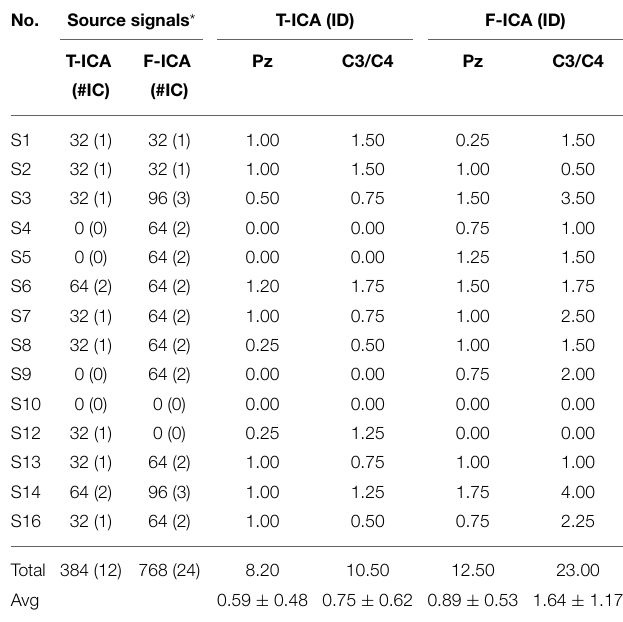
* Numberofsourcesignalswasdefinedasthenumberofelectrodes32timesthenumber of Independent Components (#IC; Figures 4 , 7 ) found for each patient. The number of source signals from all 14 patients was added to obtain the total source signals. ID: Spatial distribution of source signals is denoted by color circles and color intensity on the map ( Figures 4 , 7 ). Each circle was given an intensity distribution (ID) value from 0 to 1 based on the calculation described in “Methods.” The above ID value was the sum of the values in parietal-occipital area (Pz) and sensorimotor area (C3 and C4), respectively. Sum of ID value: 0, no signal; < 1.0, weak signals; ≥ 1.0, strong source signals